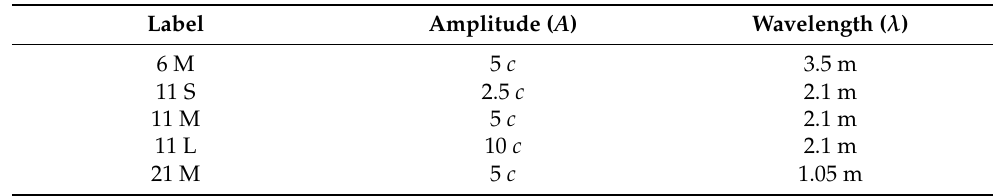
Figure 4. The shape change of the CRM wing’s leading edge after ice accretion and the description of the bionic leading edge position. Table 2. Naming methods for